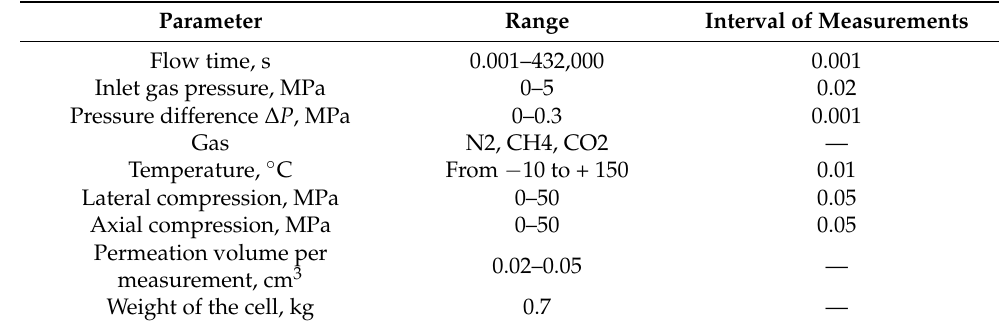
Table 1. The main parameters of the laboratory apparatus used to study the gas permeability of rocks [23].